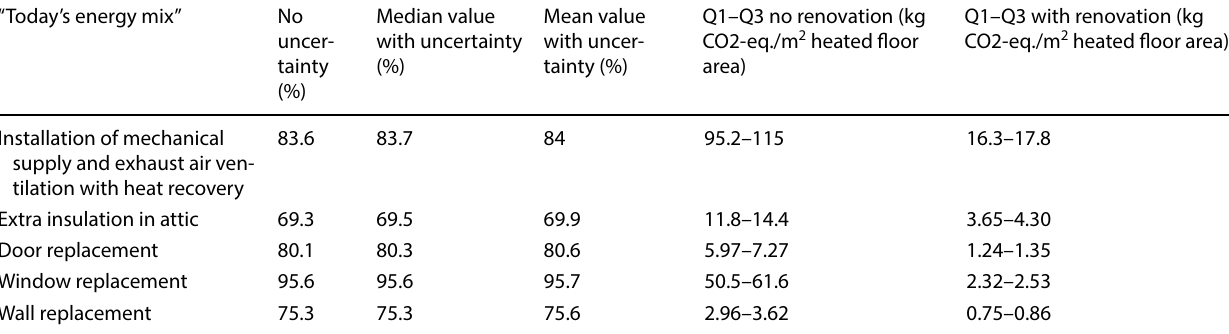
Table 5 The 1st quartile to the 3rd quartile climate change poten- tial for all renovation measures using the “Today’s energy mix”. The percentage differences in the climate change potential after carry- “Today’s energy mix”